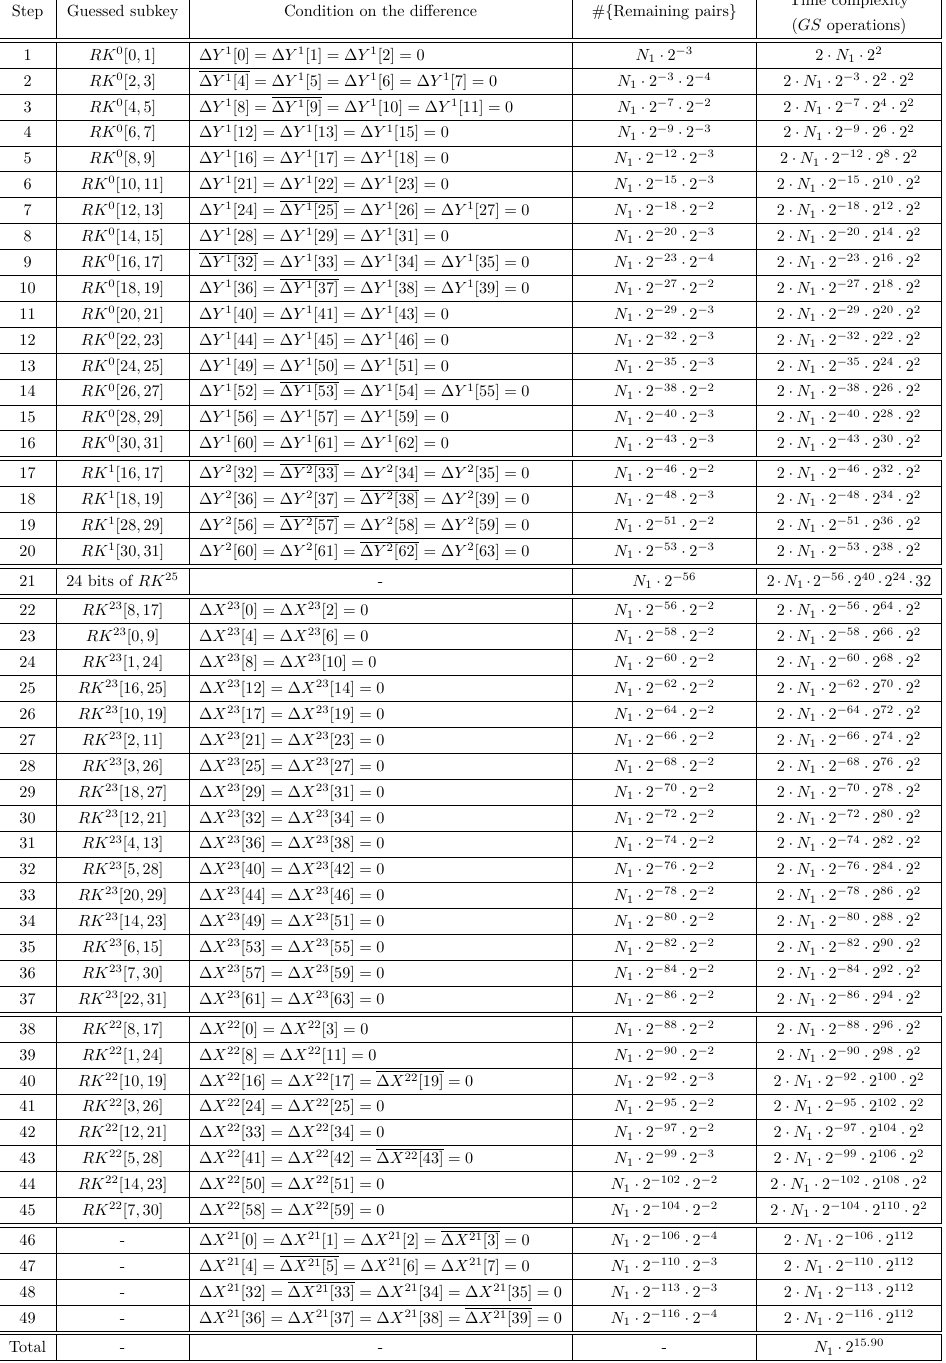
Table 11: Detailed computation of